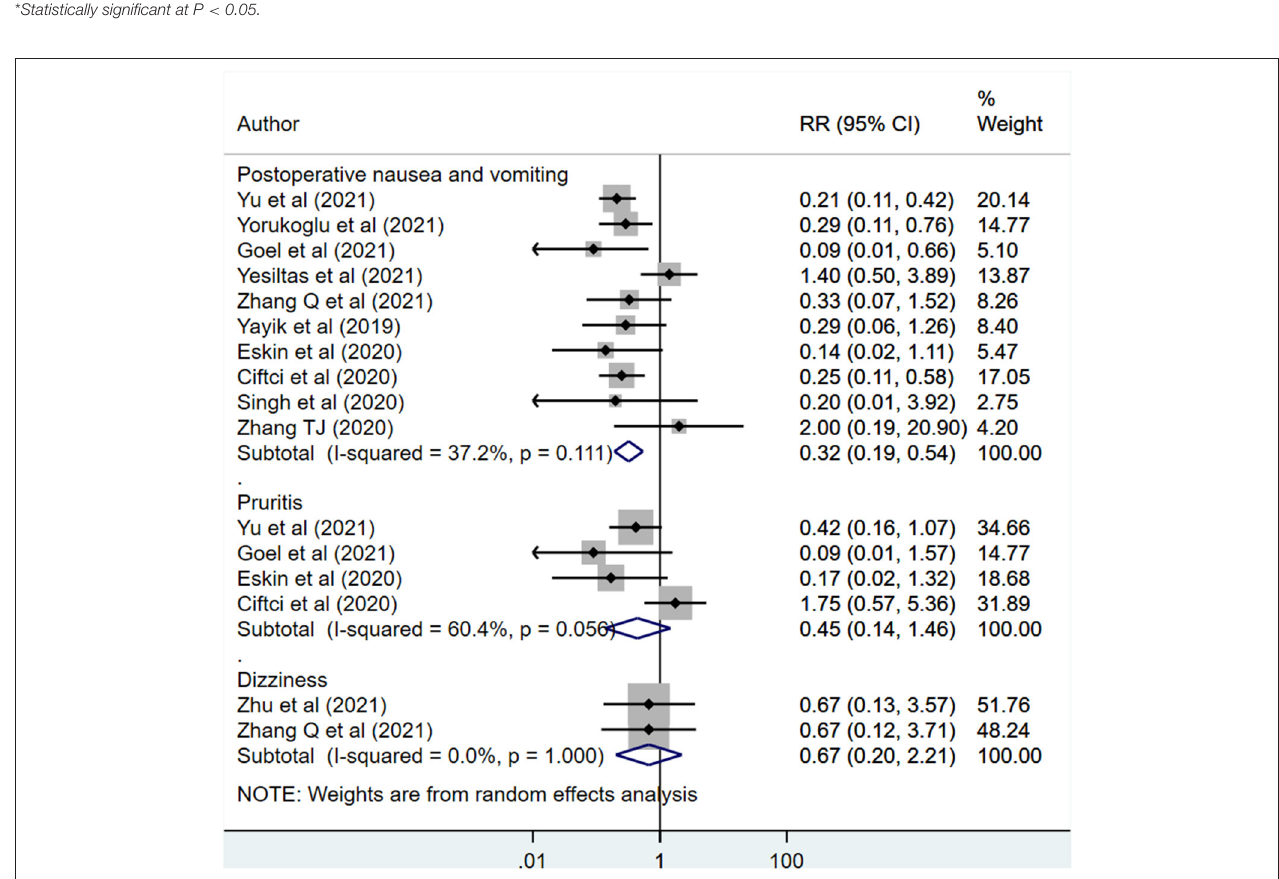
FIGURE 6 | Risk of complications among subjects with erector spinae plane block, compared to placebo or no